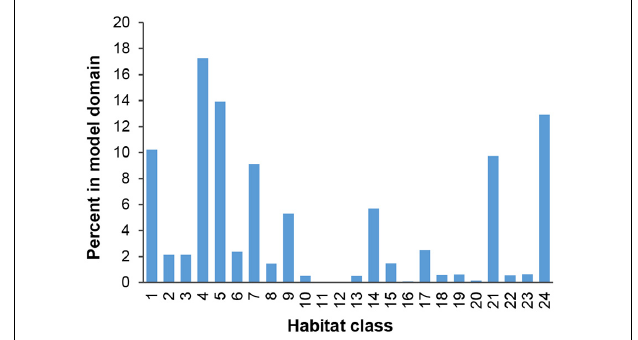
FIGURE 7 | Percentage of model domain within each habitat class.